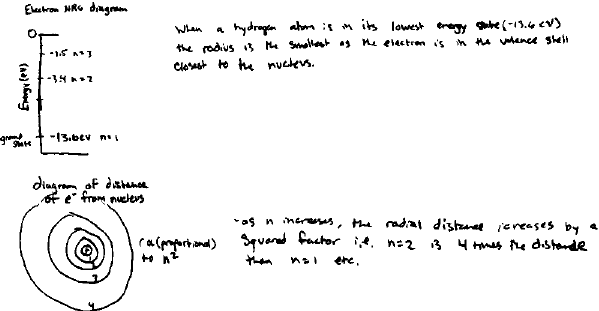
FIG. 4. Example of a student response coded as implicitly using the Bohr model only. This student described the electron as if it had a fixed radius and drew orbits of fixed radii, a characteristic of the Bohr model.